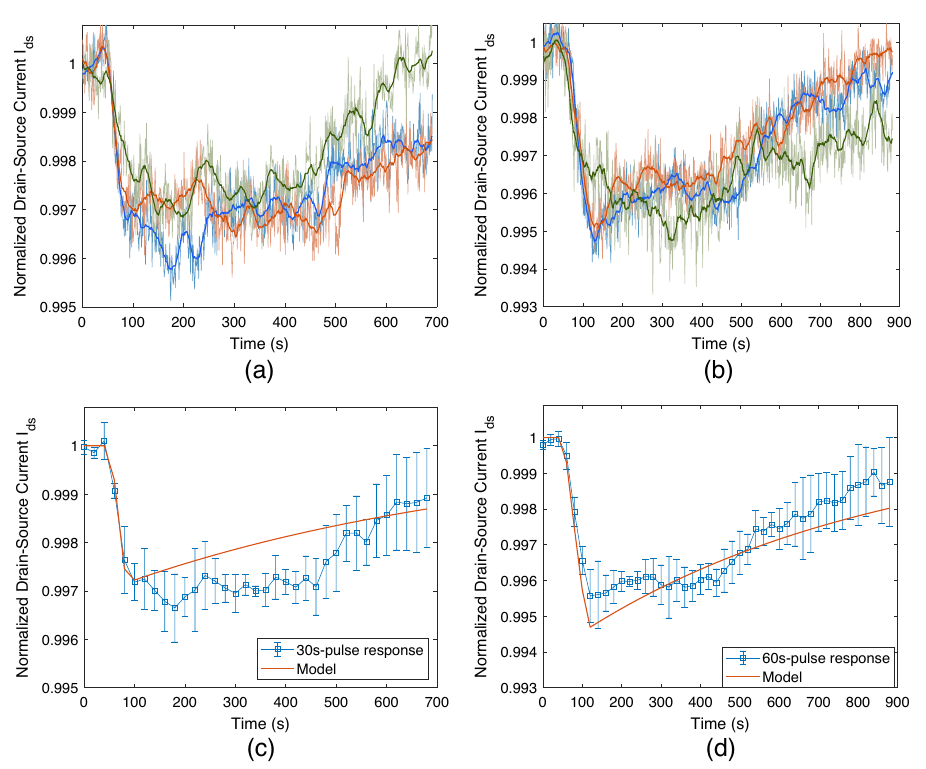
Figure 12. Normalised pulse response of the MC receiver in terms of drain-source current I ds with constant 0 V and V 0.1 V. ( a , b ) Three independent measurements taken from the operating voltages set to V g ds = = same channel for 30-second-long and 60-second-long 1 μM tDNA pulses, respectively. ( c , d ) Pulse responses fitted by the normalised output of the transformed model given in